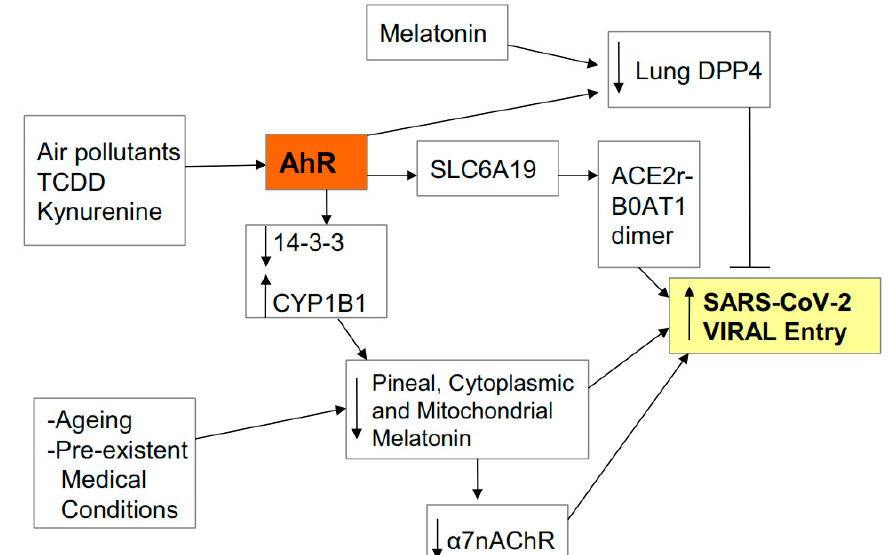
Figure 2. AhR activation by air pollutants, kynurenine or 2,3,7,8-tetrachlorodibenzo-p-dioxin (TCDD) regulates viral entry, including via SLC6A19 gene activation and B0AT1 induction. B0AT1 forms a dimer with the ACE2r which stabilizes the severe acute respiratory syndrome-coronavirus-2 (SARS-CoV-2) virus and greatly potentiates viral entry. Other dimers/partners of the ACE2r may form a similar function, including TMPRSS2 in the lung. The ACE2r and its partners require to be within lipid rafts, where the presence and/or activation of the α 7nAChR in rafts inhibits viral entry. The putative beneficial effects of nicotine against viral entry seem mediated by an increase the levels and activation of the α 7nAChR. Ageing, pre-existent medical conditions and AhR activation inhibit melatonin, thereby suppressing the melatonin induction of the α 7nAChR. AhR activation, like melatonin, may suppress viral entry by decreasing viral entry via another receptor (lung DDP4).